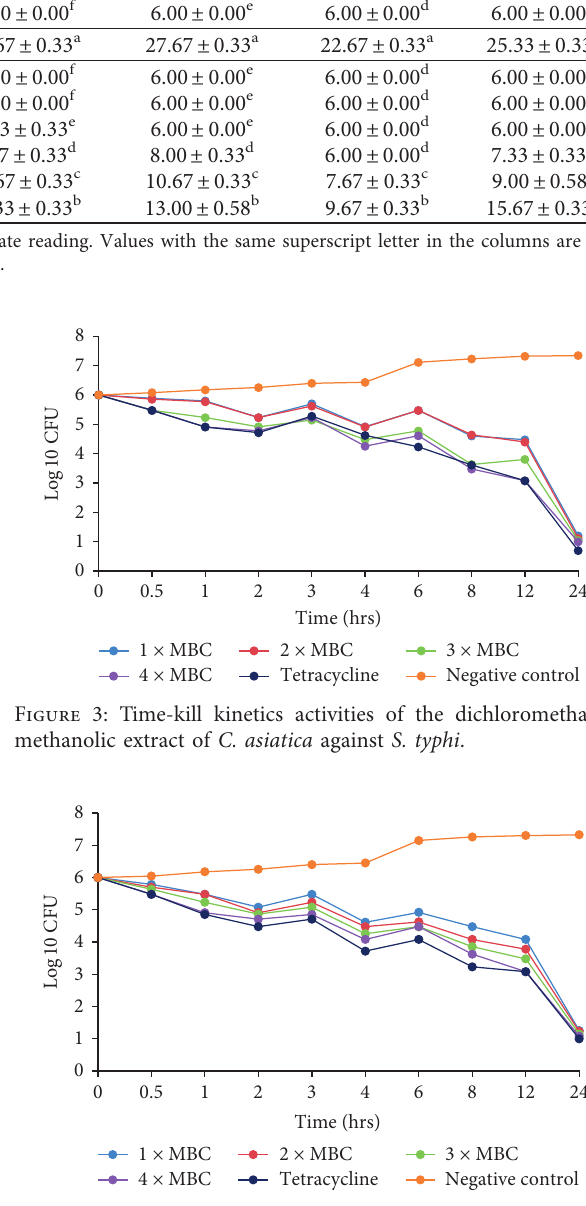
Figure 4: Time-kill kinetics activities of the dichloromethane: methanolic extract of C. asiatica against Shigella sonnei